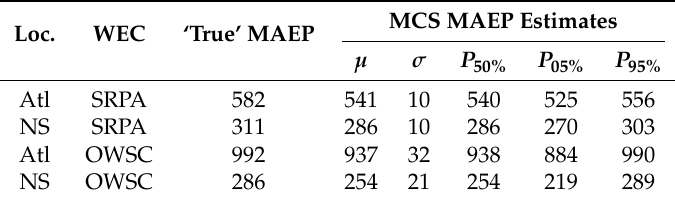
Table 5. Results from the MCS for historic met-ocean data length of 10 years and WEC deployment length of 12 months. MAEP results in units of MW-hr. Loc.